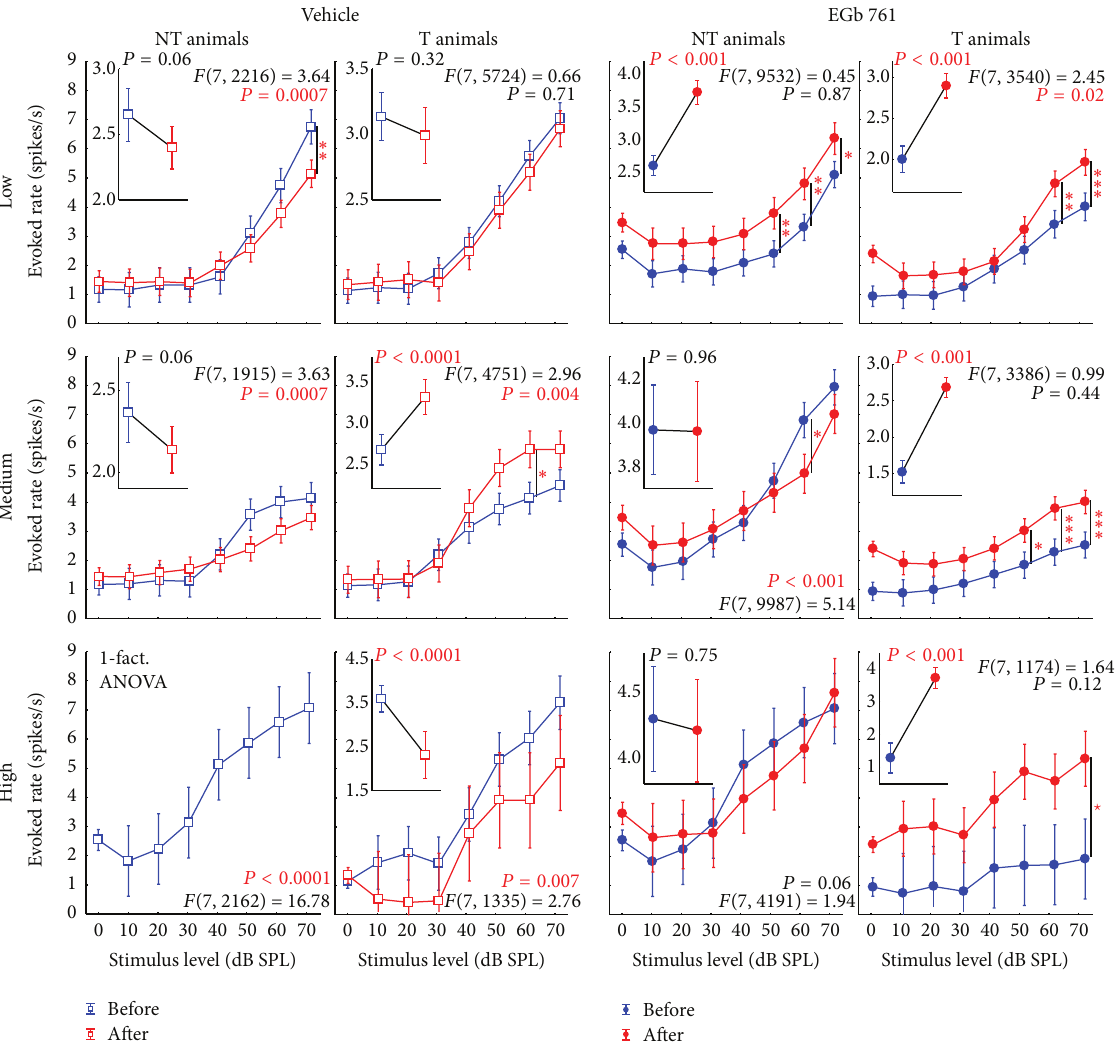
Figure 14: Level functions of the evoked spike rates in the auditory cortex of NT and T animals grouped into vehicle and EGb 761 treated groups. The mean evoked response rates of the auditory neurons in AI ( ± 95% confidence interval) as a function of stimulus level grouped as in Figure 8 are